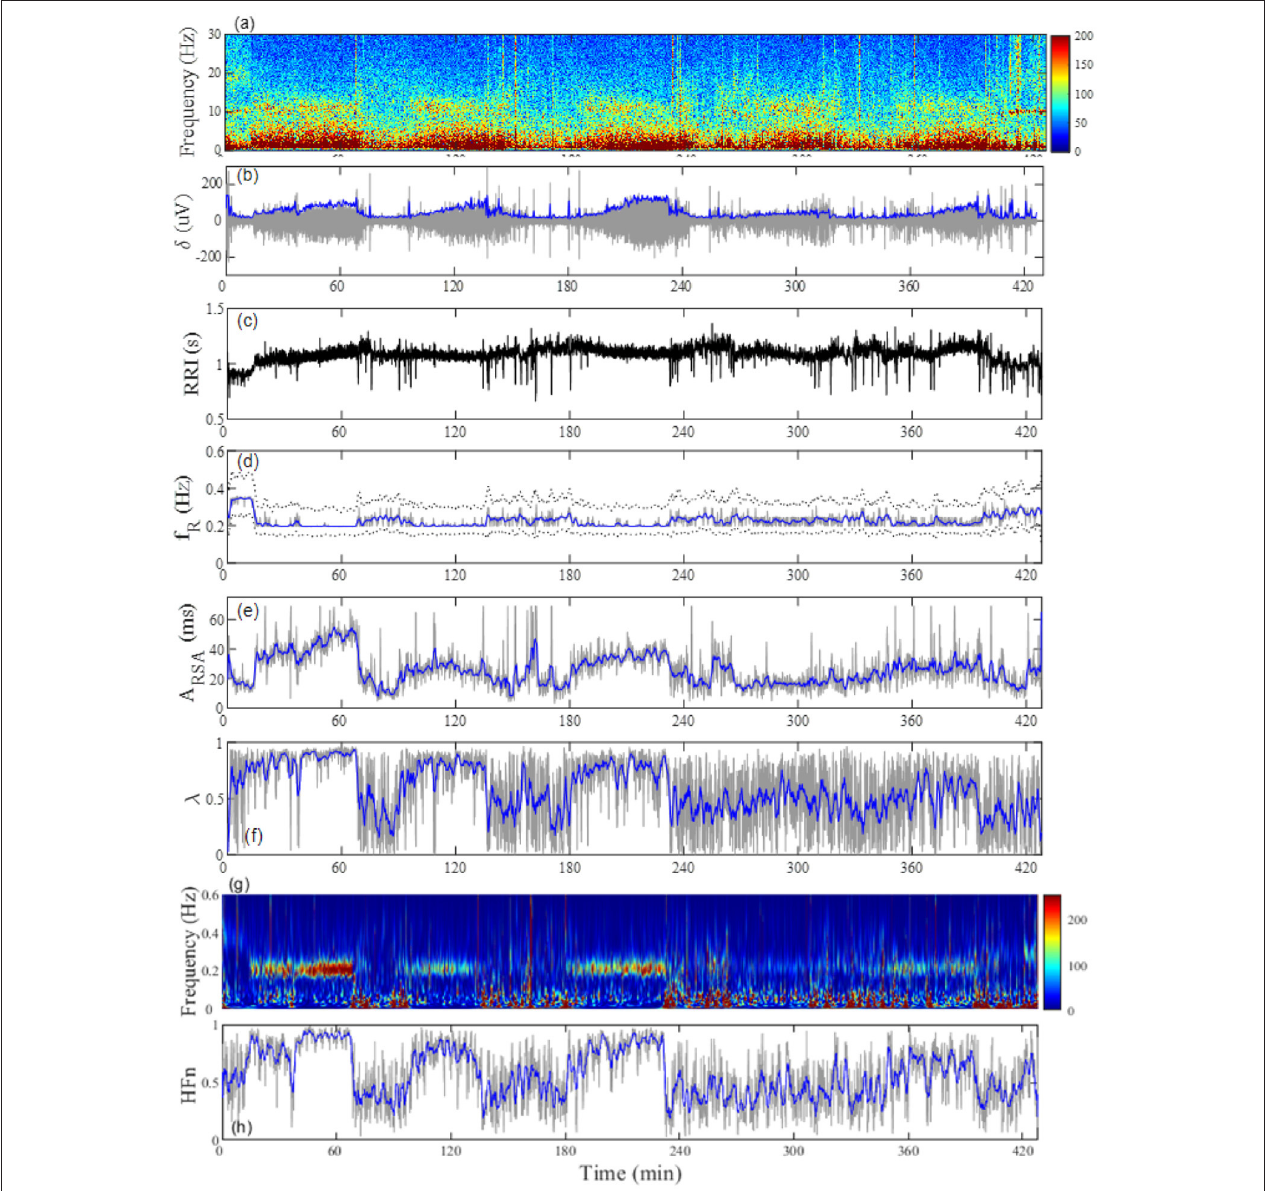
FIGURE 2 | Representative profiles of the (A) EEG frequency decomposition, (B) extracted EEG δ -wave, (C) RRI, (D) breathing frequency (f R ), (E) amplitude of respiratory sinus arrhythmia (A RSA ), (F) phase coherence ( λ ) between RSA and respiration, (G) time-frequency representation (TFR) for the change in RRI by using a continuous wavelet transform, and (H) normalized high-frequency component (HF n ) of RRI fluctuation estimated from TFR in a 24-year-old man. The gray line in (B) indicates the amplitude of the EEG δ -wave and the blue line depicts the envelope. The dotted lines in (D) indicate the full width at 20% maximum of the power spectral density for breathing, which was used as the passband frequency for determination of RSA. The gray lines in (D–F,H) are respective values estimated from 20-s windows and the blue lines indicate general trends obtained by applying a median filter (2-min moving